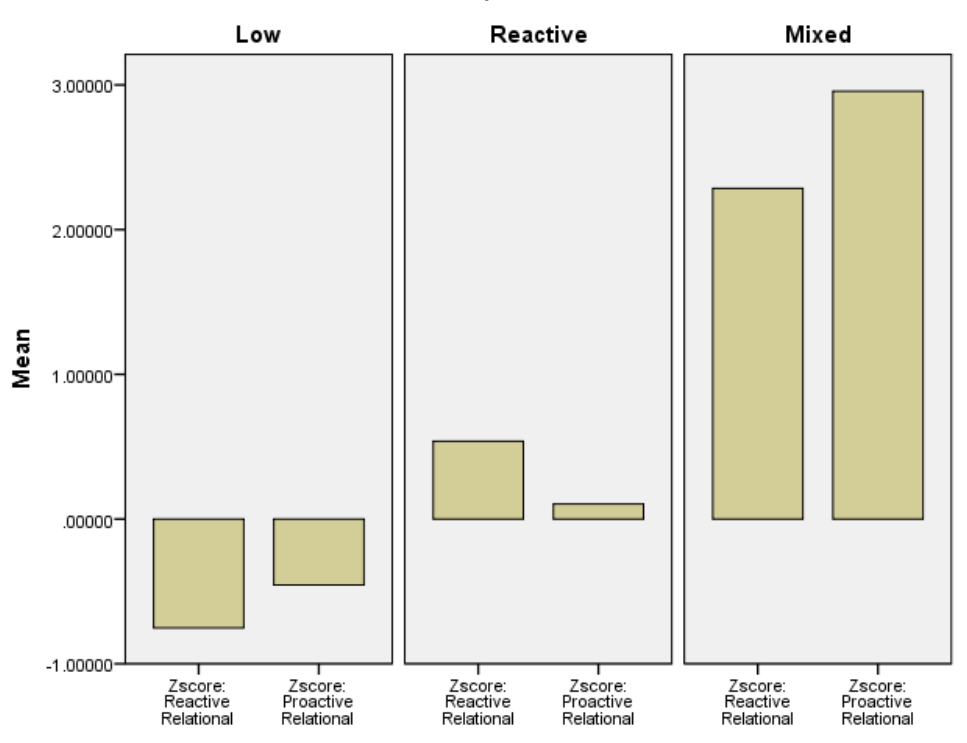
Figure 1. Profiles of reactive and proactive relational aggression resulting from two-step cluster